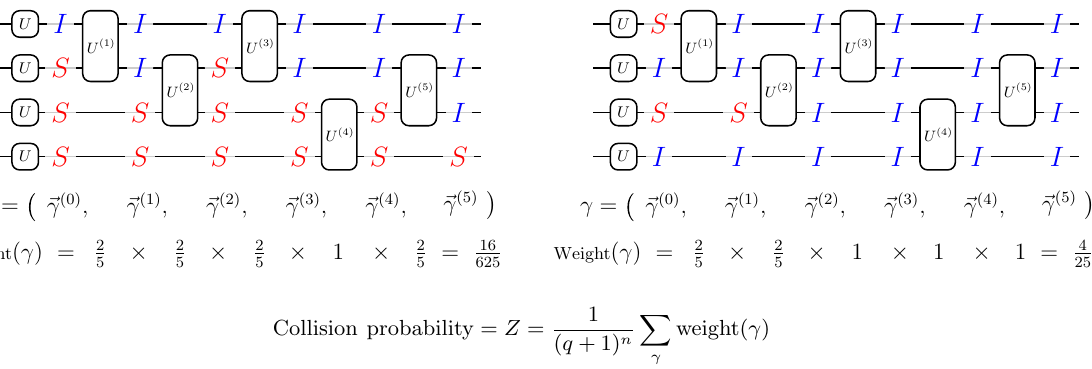
FIG. 2. Two example trajectories for a quantum circuit diagram with n = 4 qubits and s = 5 gates. Each gate displayed is chosen randomly from the Haar measure over single- or two-qubit unitaries. The collision probability Z is expressed as a weighted sum over trajectories γ = ( (cid:16) γ ( 0 ) , . . . , (cid:16) γ ( s ) ) , which are length- ( s + 1 ) sequences of assignments (“configurations”) of I or S to each of the n qudits. When the input bits to a gate are assigned opposite values, one must be switched at the next configuration in the sequence. These bit flips happen at gates 1, 2, 3, and 5 in the first example and at gates 1 and 2 in the second example. Each bit flip results in a reduction of the weight by a factor 2 / 5 (when q = 2). In the second example, the trajectory reaches one of the fixed-point configurations where all n values agree; this is not the case in the first example. Trajectories that quickly reach a fixed point generally have larger weights and make up most of the contribution to the collision